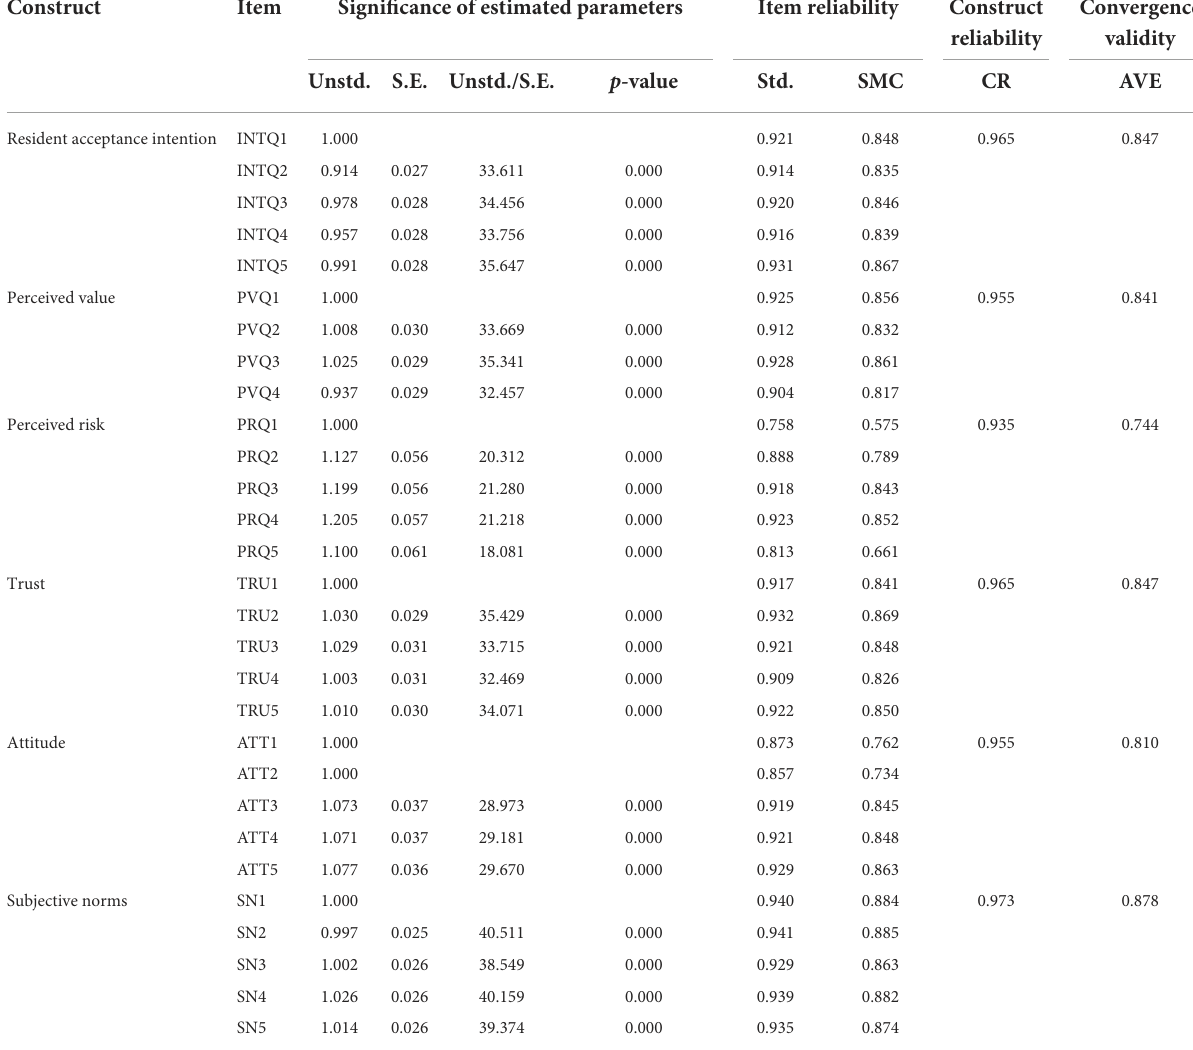
TABLE 3 Analysis of measurement pattern